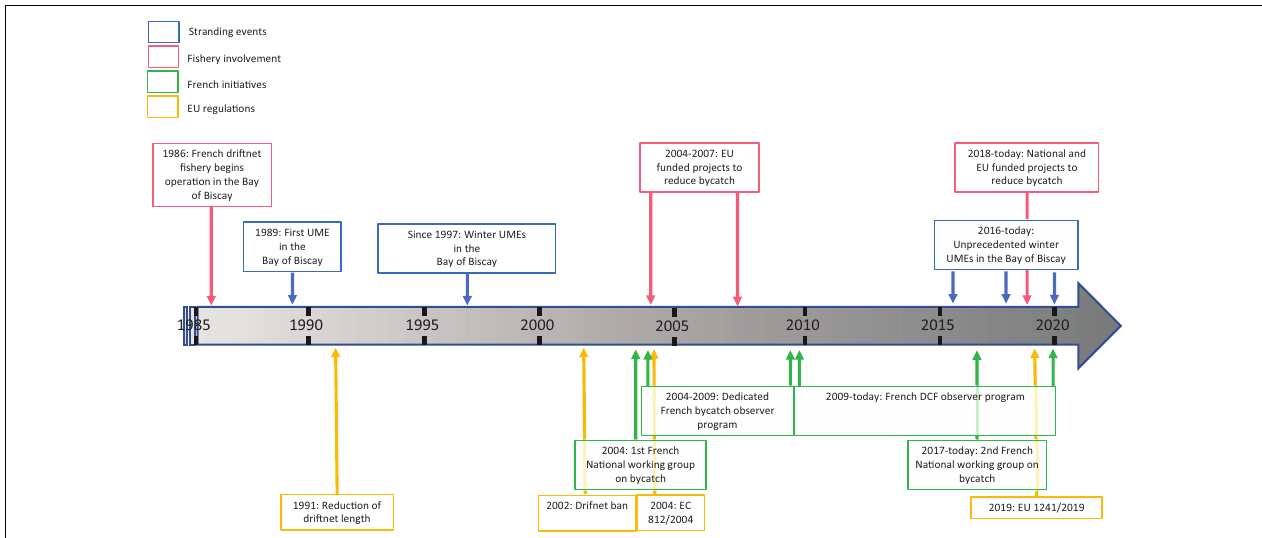
FIGURE 1 | Main historical events in common dolphin bycatch management in the Bay of Biscay. DCF, Data Collection Framework; EC, European Commission; UME, unusual mortality